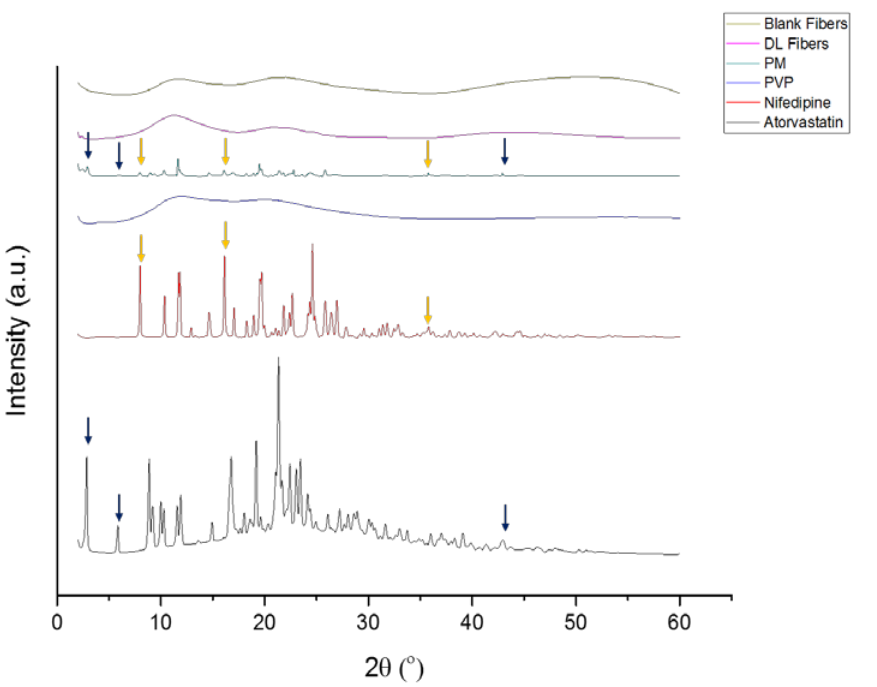
Figure 3. XRD patterns of PVP, nifedipine, atorvastatin calcium, PM, blank and drug-loaded nanofibers showing that both drugs were in the crystalline form (presence of characteristic reflections), while PVP was in the amorphous form (broad halo pattern). The presence of the drugs’ distinct peaks was presented in the PM but was absent in the drug-loaded nanofibers, suggesting the molecular dispersion of the drugs due to the electrospinning process.